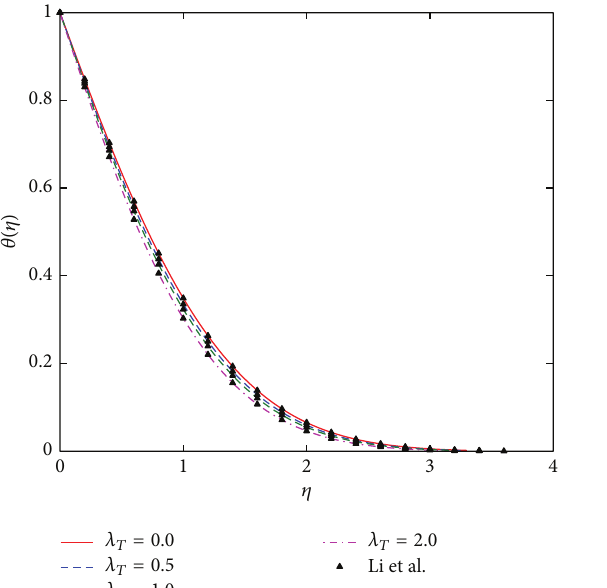
Figure6:Theeffectof 𝑘 1 onvelocityprofilewhen 𝜆 𝑇 = 0.4 ,Pr = 1.0 , and 𝑚 = 0.5 .